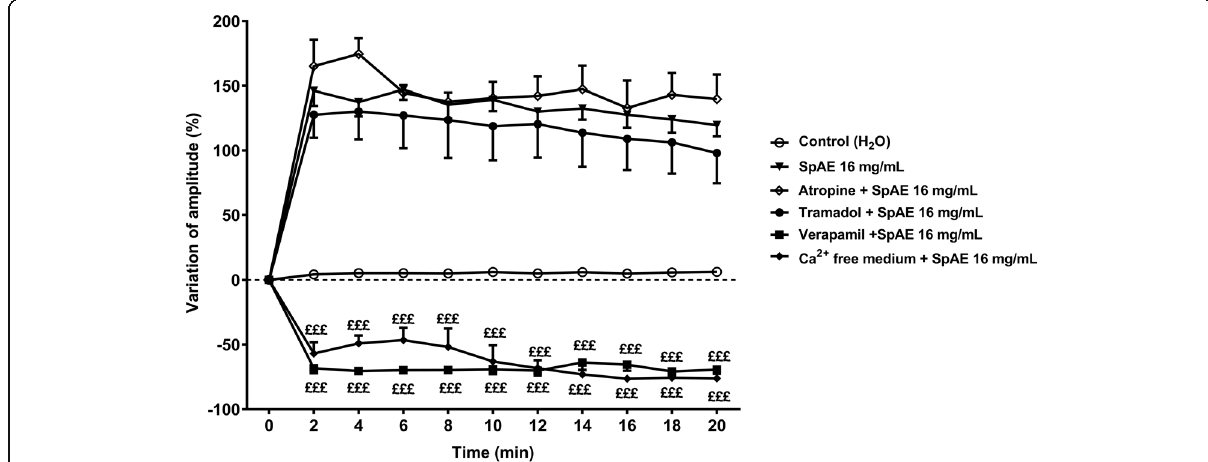
Fig. 6 Time-response curves of the effect of Sida pilosa aqueous extract and pharmacological blockers on the amplitude of spontaneous contractions of isolated rat ileum. Each point represents the mean ± SEM (n = 5). ANOVA followed by Newman-Keuls multiple comparison test was used for statistical analysis. £££ p < 0.001: values are significantly different from those recorded with SpAE 16 mg/mL at each time